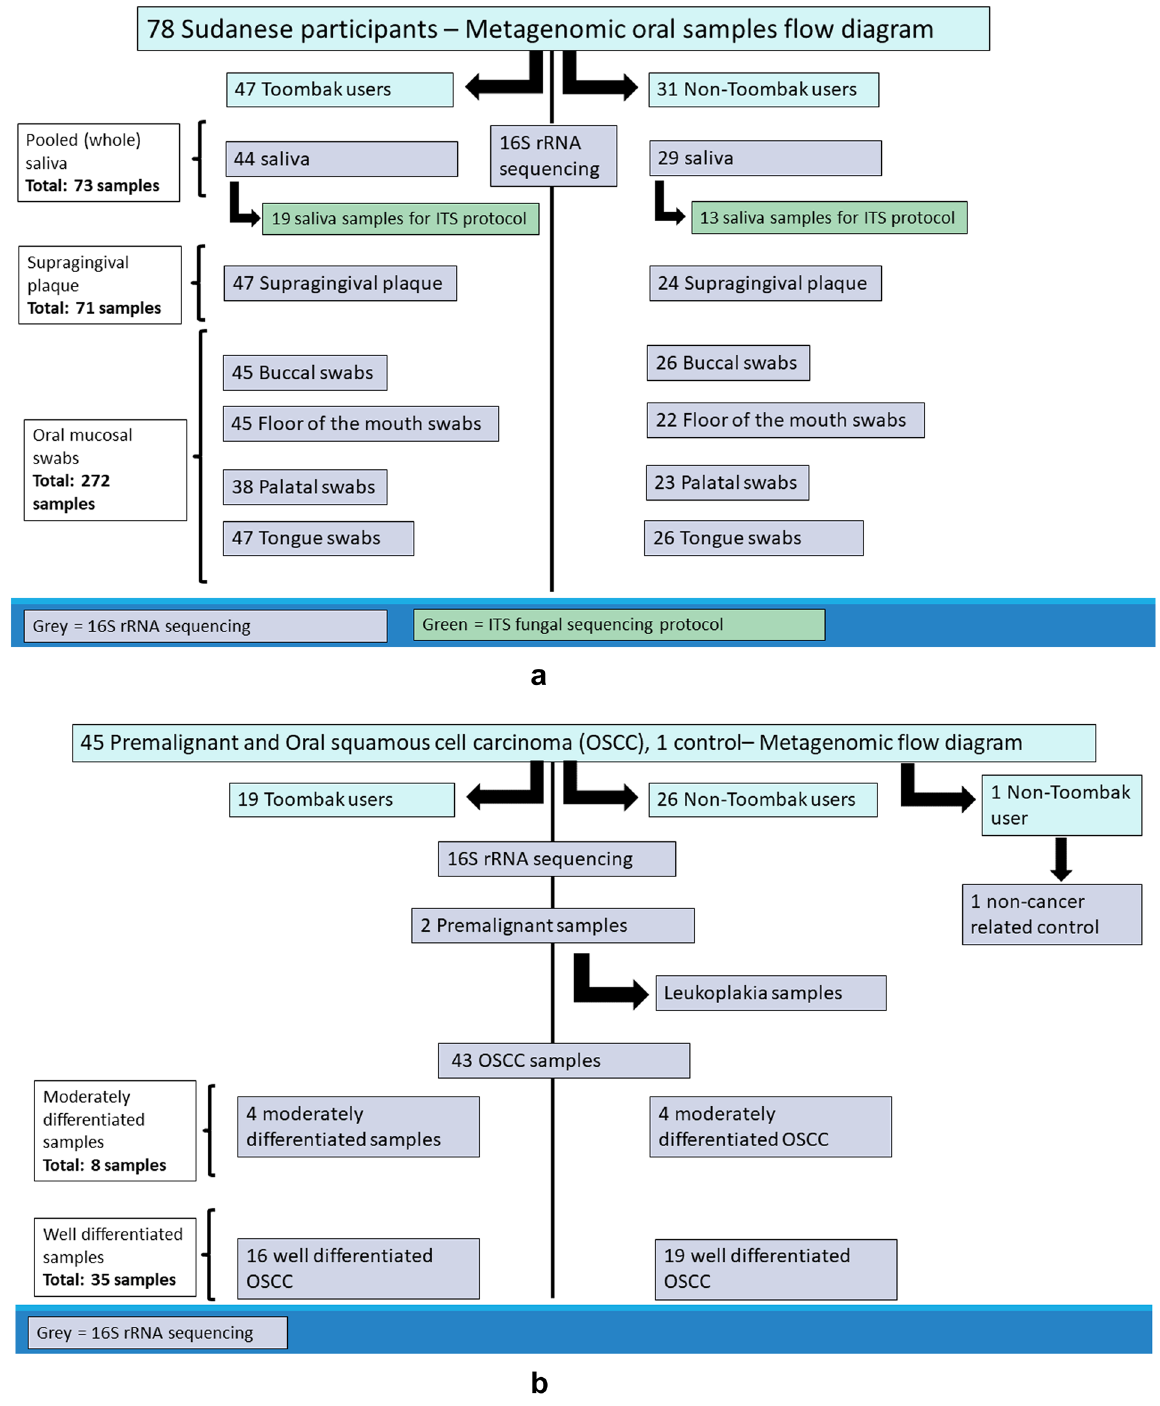
Figure 1. ( a ) 78 Sudanese participants – Metagenomic oral samples flow diagram. Participant samples were categorised into saliva, supragingival plaque and oral mucosa swabs. ( b ) Premalignant and oral squamous cell carcinoma Metagenomic flow diagram. Samples were achieved from formalin fixed paraffin embedded tissues of premalignant, oral cancer and non – cancerous (control) DNA extraction of pooled saliva, mucosal swab, and plaque samples. DNA extraction of samples was achieved by the DNeasy Powersoil Pro Kit (QIAGEN®, Hilden, Germany). Eluted DNA was transferred to sterile Eppendorf tubes and frozen at − 80 °C for further analysis. The mucosal swabs and plaque were first cut